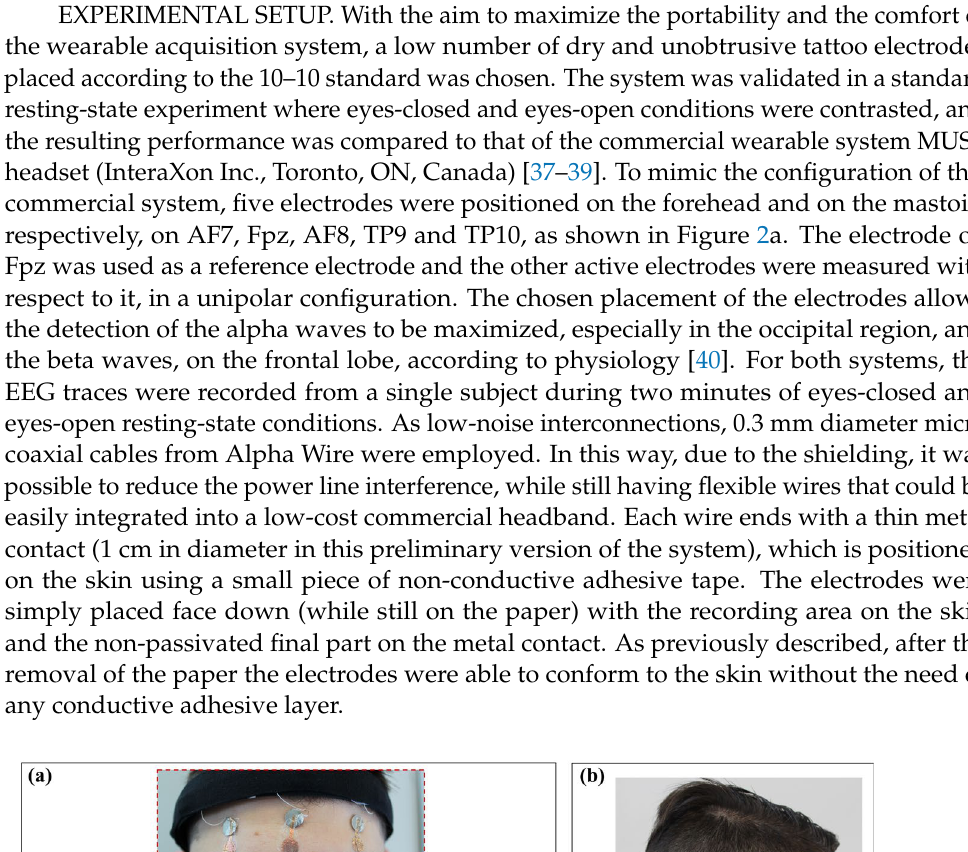
Figure 3. Exemplifying time-course of the EEG traces, channel spectra and maps for the two differ- ent acquisition systems and two different experimental conditions. EC and EO, respectively, refer to resting-state eyes-closed and eyes-open conditions. Each line represents a different channel, namely TP9 (red), TP10 (black), AF7 (green), AF8 (blue).